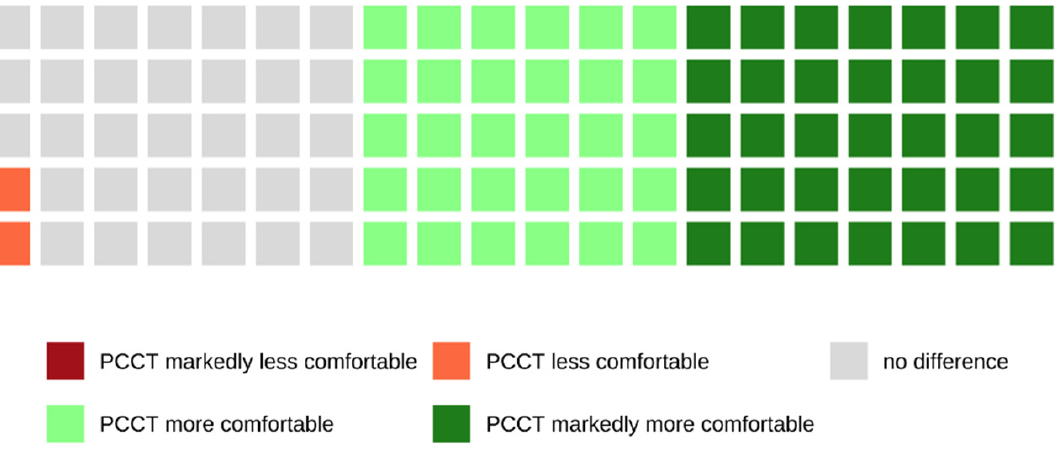
Figure 2. Waffle plot showing the comparison of both CT scanners in terms of claustrophobia where 65.1% of patients rated the examination with the PCCT as more or markedly more comfortable compared to an examination